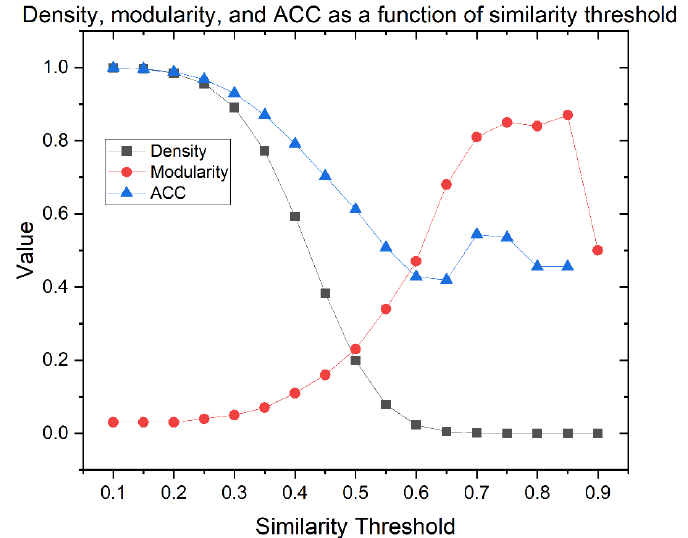
Figure 4. Density, modularity, and average clustering coefficient (ACC) as a function of similarity threshold of 627 THPs CSN.